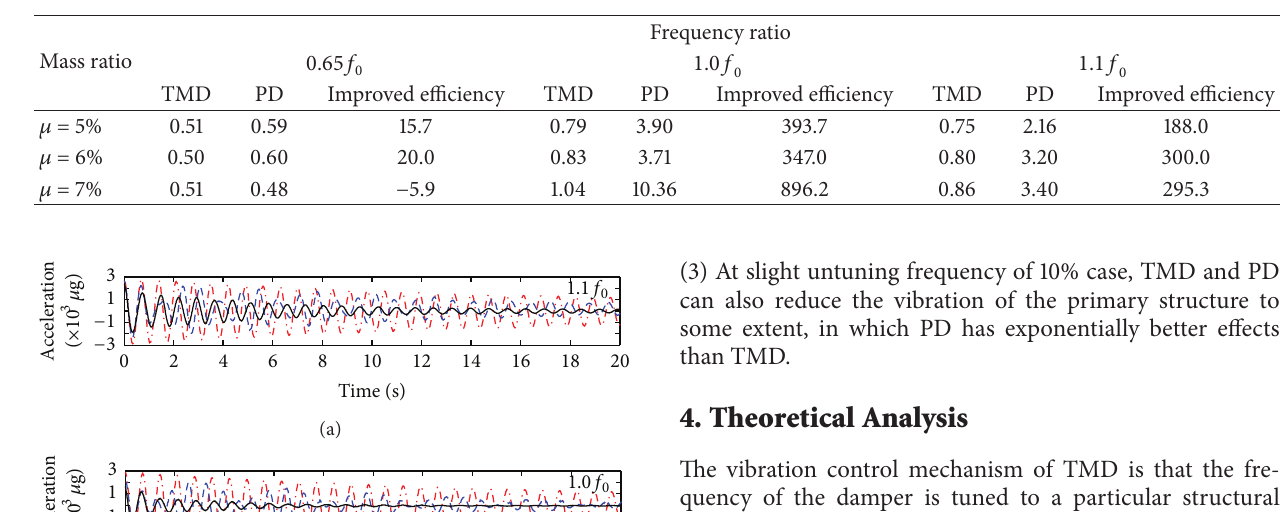
Table 1: Equivalent damping ratios of the primary structure at different cases (%).